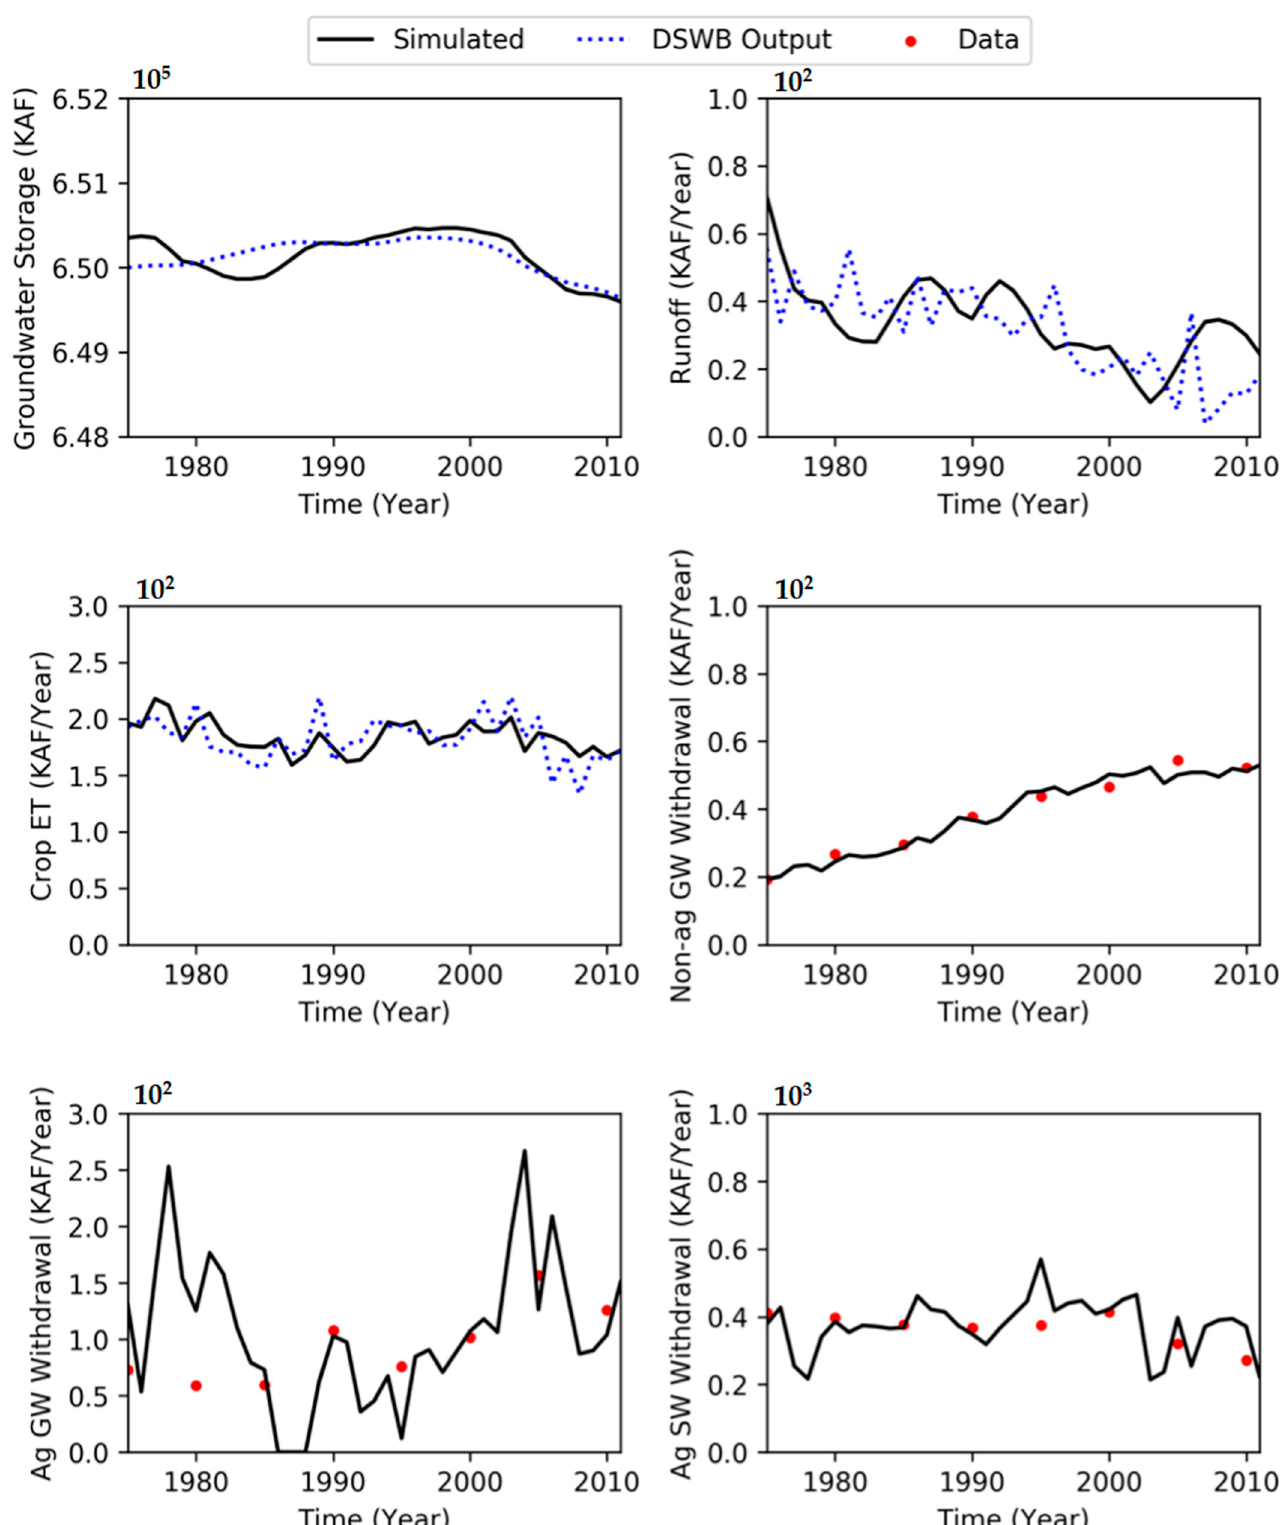
Figure A1. Behavior reproduction results (water variables).